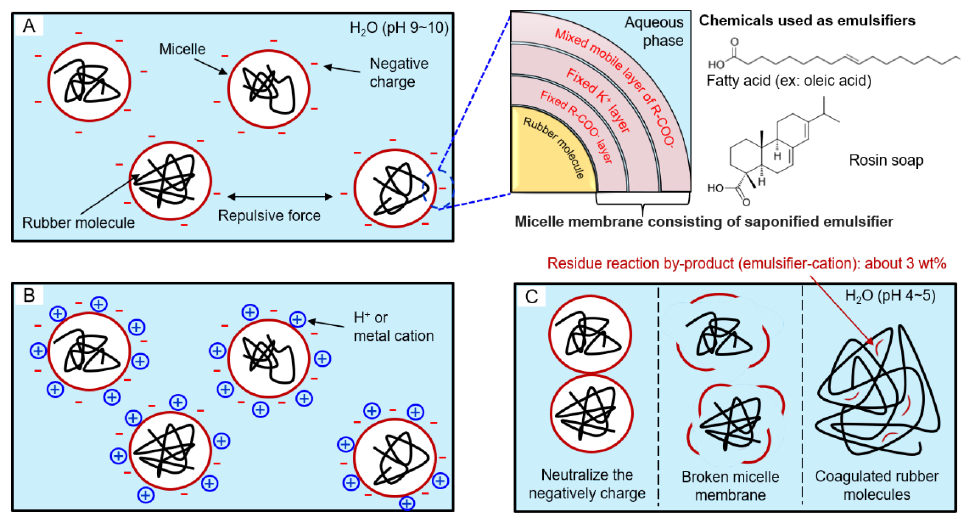
Figure 1. Coagulation mechanism of synthetic rubber such as emulsion styrene-butadiene rubber (ESBR): ( A ) a state in which a micelle having a negative surface charge is dispersed in water, ( B ) a state after adding coagulant in latex, and ( C ) a state of micelle destruction due to collision between neutralized micelles.